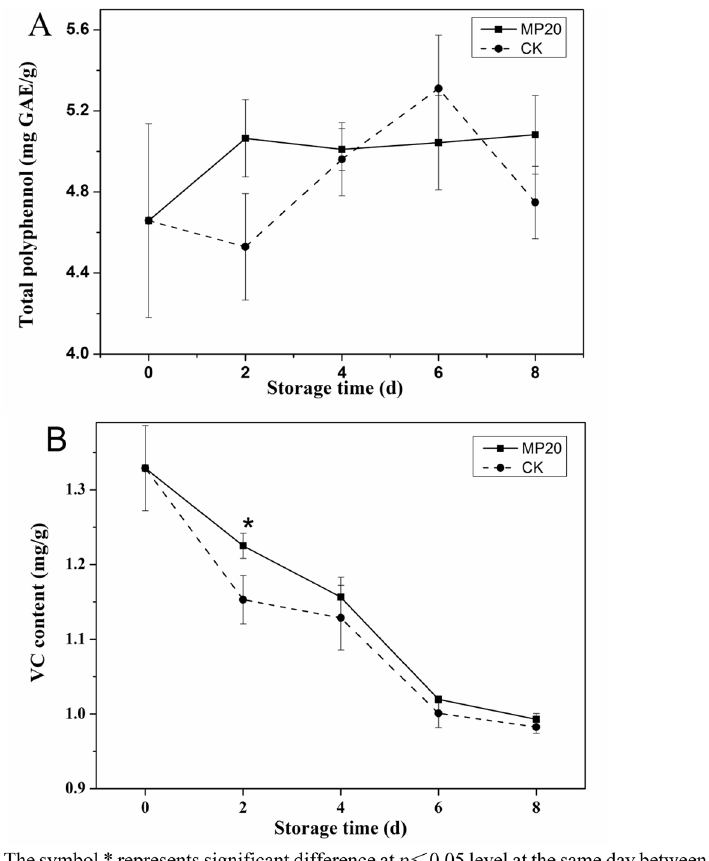
Figure 3. Effect of packaging on total polyphenol content ( A ) and vitamin C content ( B ) of mulberry leaf vegetable during storage. Error bars indicate standard deviation. Asterisks indicate significant differences at the same storage time ( p <